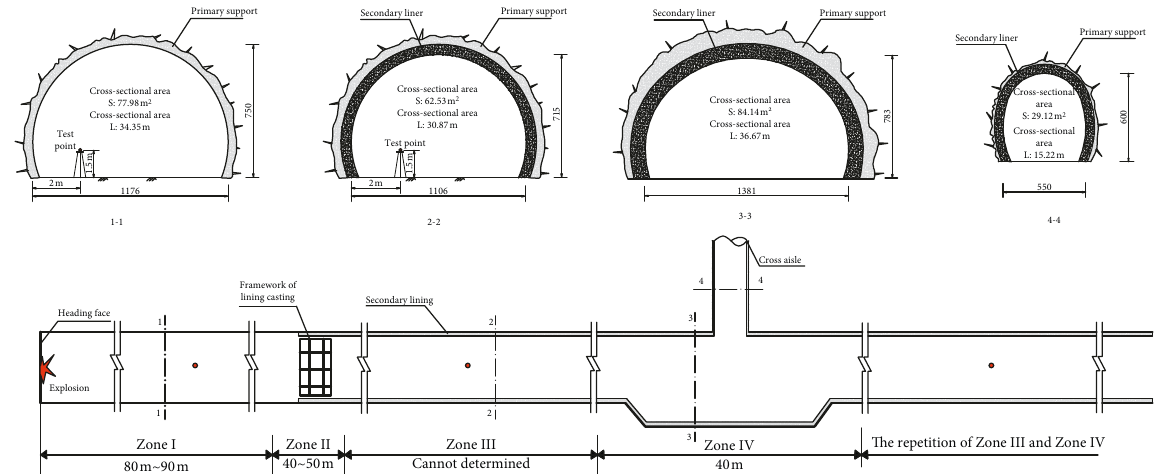
Figure 2: Profiles of the Micangshan highway tunnel near the explosion